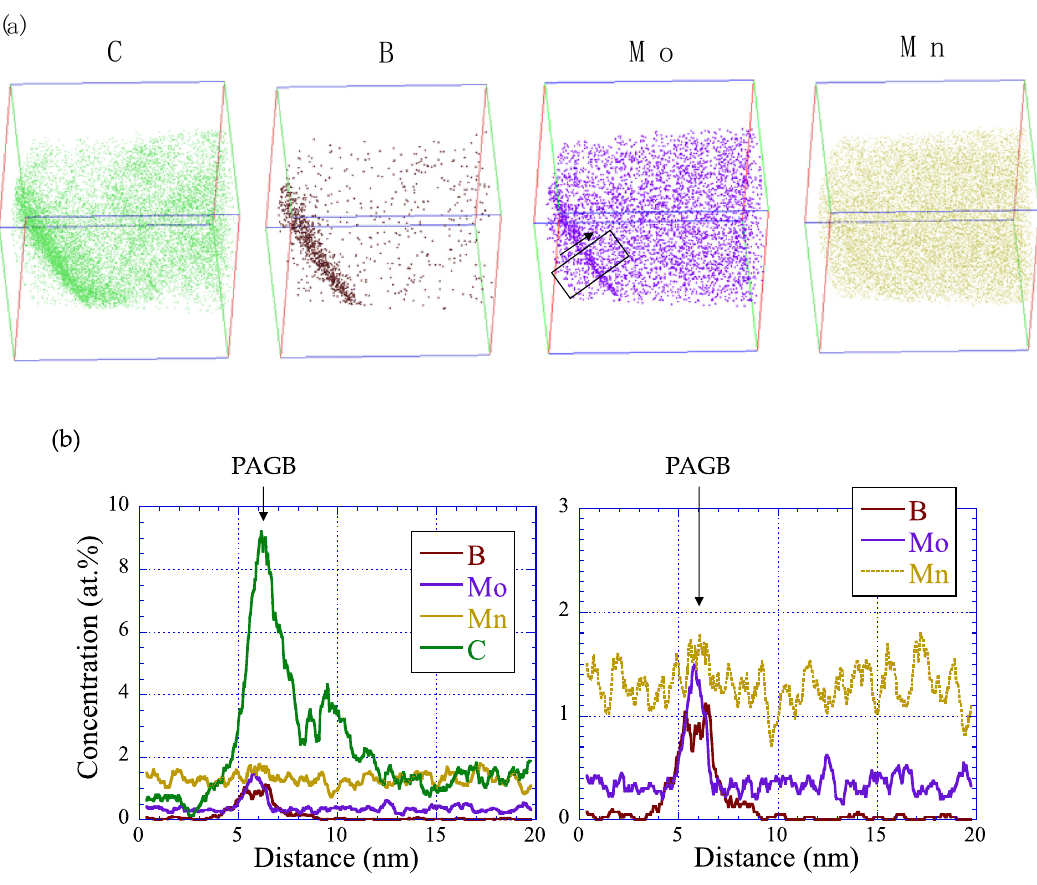
Figure 12. Atom probe tomography results of the region around the prior austenite grain boundary (PAGB) of the 0.5% Mo alloy (CT: 400 ◦ C, short heat treatment cycle). ( a ) The 3D elemental maps of the elements, carbon, boron, molybdenum and manganese, in a reconstruction volume of 85 nm × 85 nm × 158 nm; ( b ) the 1D concentration profiles in the area and direction indicated in ( a ).